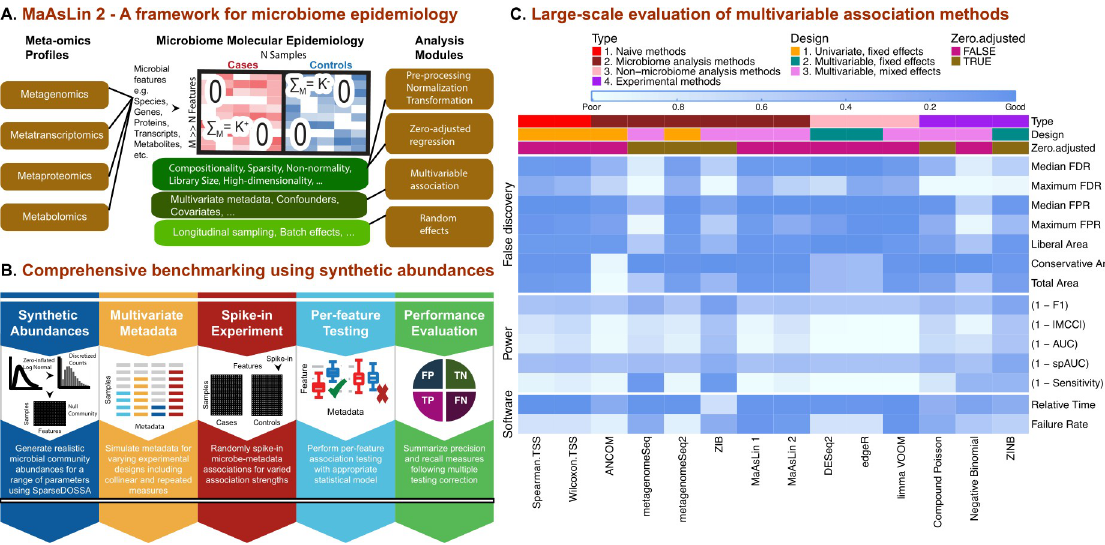
Fig 1. MaAsLin 2 for feature-wise association of microbial communities with phenotypes. A ) MaAsLin 2 is a statistical method for association analysis of microbial community meta-omics profiles. It comprises several steps, including data transformation, multivariable inference, multiple hypothesis test correction, and visualization. These are based on a set of flexible and computationally efficient linear models, while accounting for the nuances of microbiome data, repeated measures, and multiple covariates. B) Comprehensive benchmarking of multivariable methods for microbiome epidemiology. To identify appropriate methods for associating microbiome features with health outcomes and other covariates, we assessed up to 84 combinations of normalization/transformation, zero-inflation, and regression models ( S1A Fig ). These were applied to synthetic data using a hierarchical model (SparseDOSSA, http://huttenhower.sph.harvard.edu/sparsedossa) to generate realistic, model-agnostic datasets with varying scopes and effect sizes of microbiome associations. Individual per-feature association methods were performed repeatedly to evaluate method-specific recall and precision measures. C ) Association method performance summary across major evaluation criteria. Three aspects of performance were considered: (i) false discovery, (ii) sensitivity, and (iii) computational efficiency. Evaluation metrics ( S1B Fig ) are shown (in rows) for the resulting microbial multivariable association methods (both state-of-the-art and novel), averaged over all simulation parameters ( S1A Fig ). The top-performing methods (as measured by average F1 score) from each class of models ( S1C Fig ) are shown (in columns). Except for Spearman and Wilcoxon that maintained best performance on TSS-normalized data, all methods exhibited superior performance with no/default normalization (ANCOM, metagenomeSeq, metagenomeSeq2, DESeq2, edgeR, MaAsLin 1, MaAsLin 2, limma VOOM, ZIB) or library size normalization in which log-transformed library size is included as an offset in the associated GLM likelihood (Compound Poisson, Negative Binomial, ZINB). Top colored boxes represent method characteristics including the capability to handle zero-inflation and random effects. Based on synthetic evaluations, MaAsLin 2 includes optimized default models for epidemiological testing in microbial multi-omics